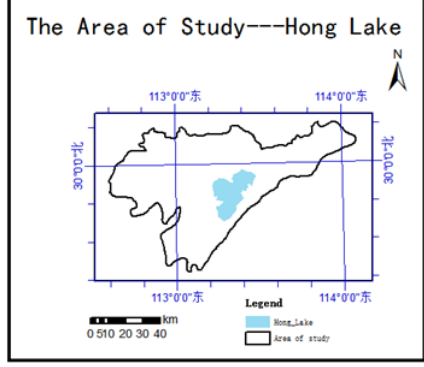
Figure1: The area of study.